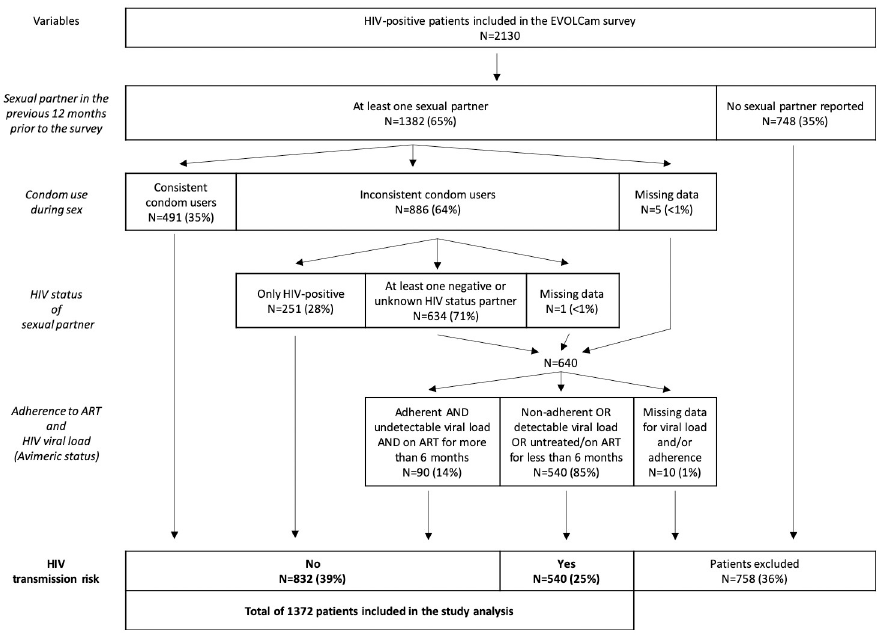
Fig 2. Flow chart of the study population (selected participants from the EVOLCam survey, ANRS-12288).